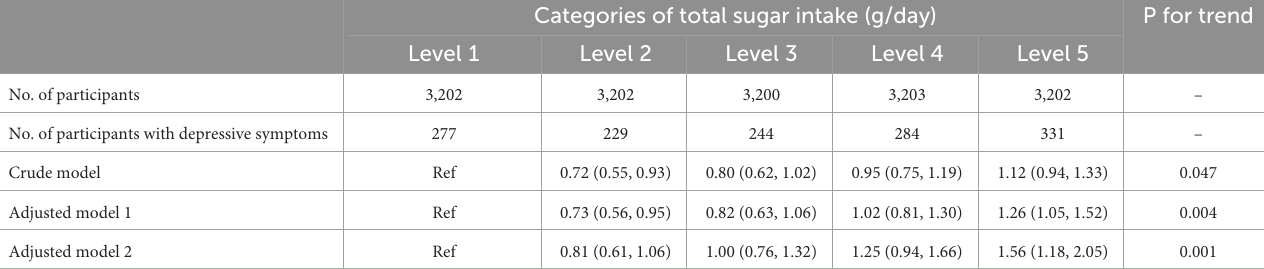
TABLE 2 Association between total sugar intake and depressive symptoms.